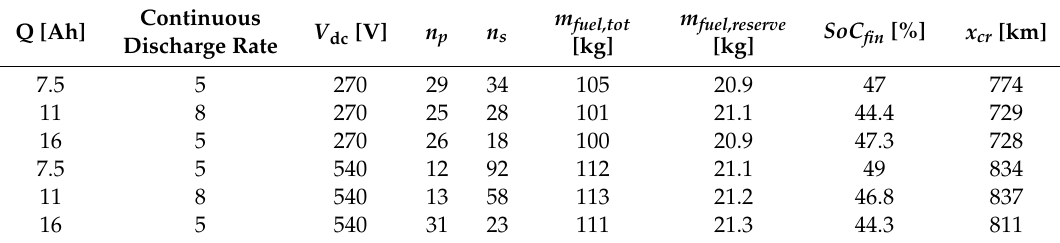
Table 6. Problem 2 for di ff erent cells and DC-link voltages.